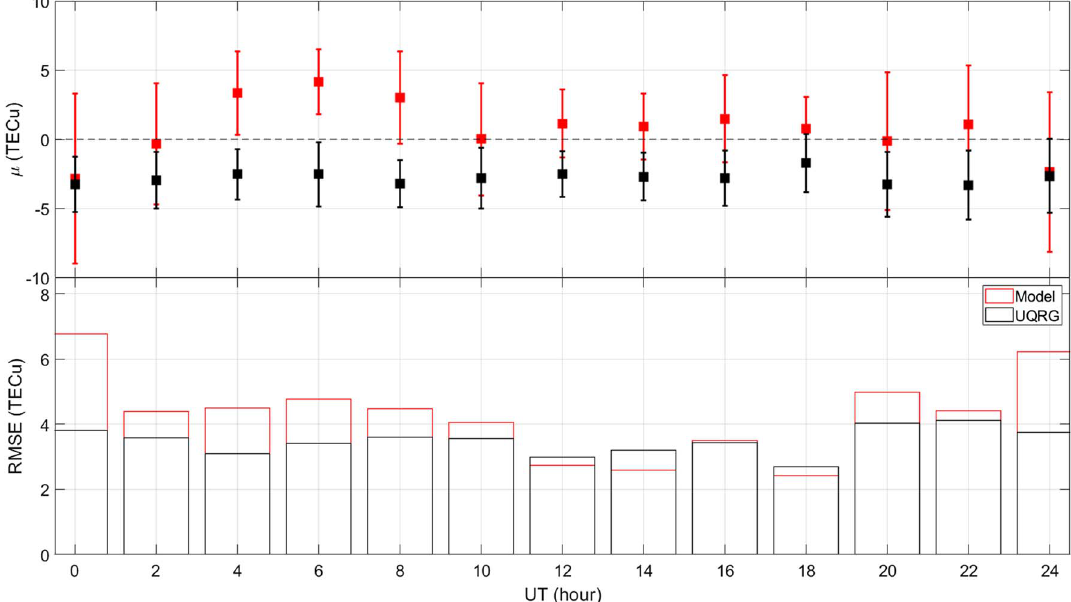
Fig. 14. Time dependence of the performance against JASON-3 for 08 February 2018 of the Long-Term forecasting model (red) and of the UQRG product (black). Top plot: mean difference with JASON-3 vTEC measurements and the error bar is the 1-sigma spread. Bottom plot: RMSE of the